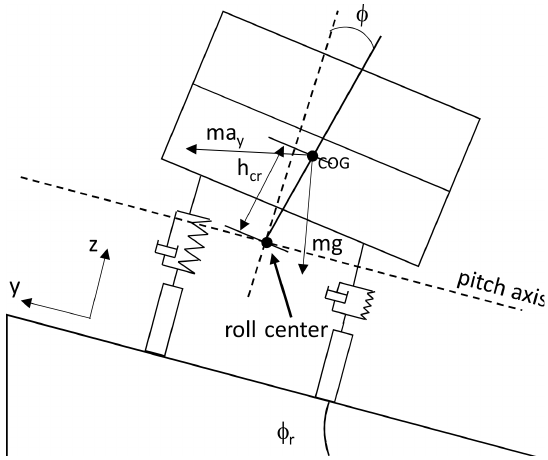
Figure 3. Vehicle model used in the controller